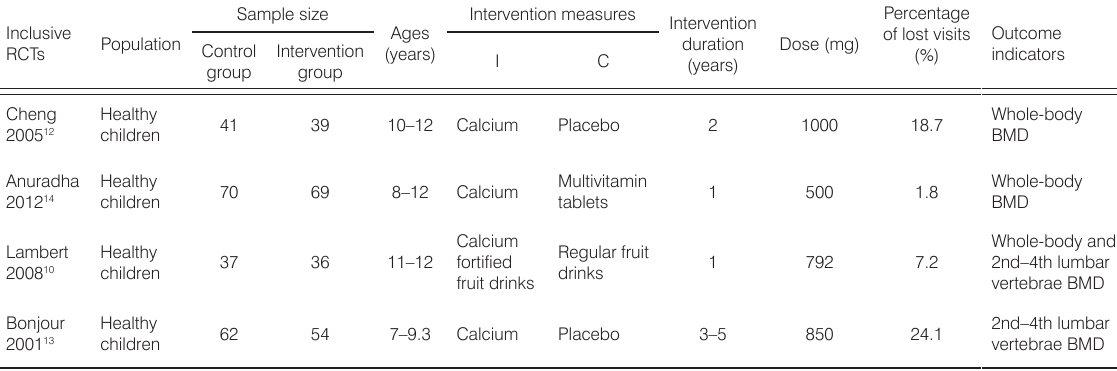
Table 1. Basic characteristics of included RCTs.